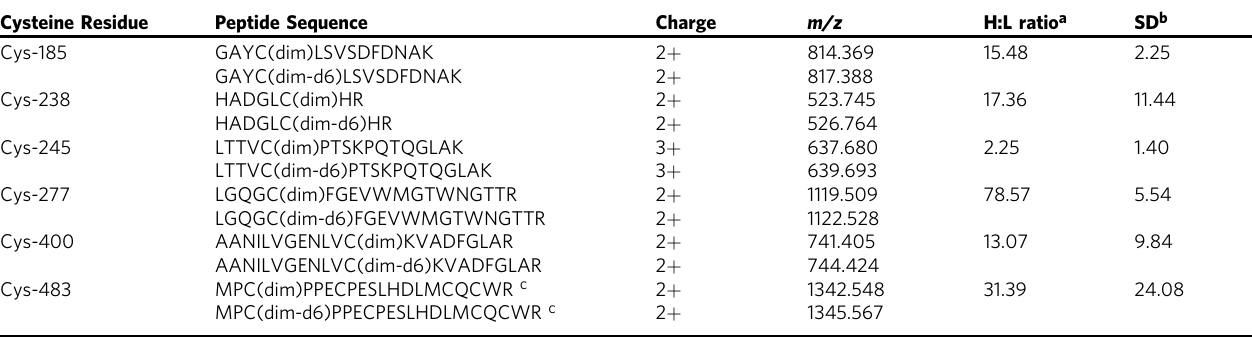
All dimedone/dimedone-d6 labeled Src peptides were identi fi ed using targeted mass spectrometry analyses. Five out of six dimedone/dimedone-d6 labeled Src peptide pairs were quanti fi ed within an average mass error of less than 5ppm across the peak of elution. XCalibur was used to quantify MPC(dim/dim-d 6 )PPECPESLHDLMCQCWR using m/z 1342.548 → [y3] + , [y7] + , and [y13] + (dim labeled) and m/z 1345.567 → [y3] + , [y7] + , and [y13] + (dim-d 6 labeled) a Heavy to light